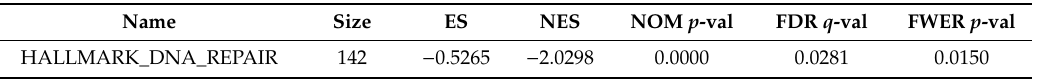
Table 2. Significant gene sets that associated with low expression of AR using Gene Set Enrichment Analysis (GSEA)(TCGA).